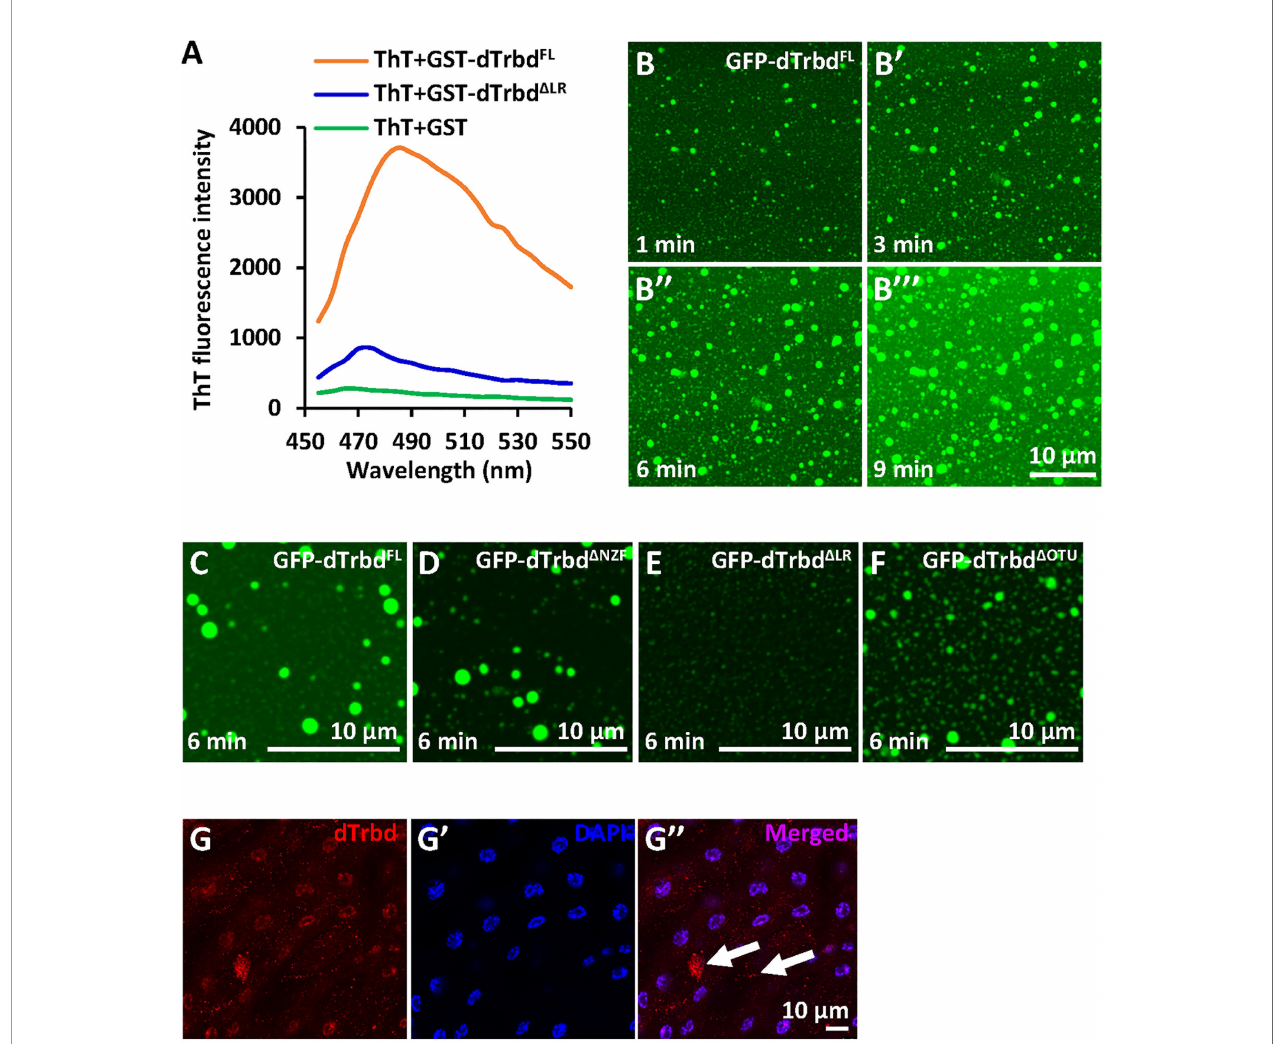
FIGURE 3 | dTrbd undergoes phase separation depending on the Linker region. (A) dTrbd FL but not dTrbd D LR binds to the amyloid binding dye Thio fl avin T (ThT). ( B-B ’’’ ) Phase separation of dTrbd FL at various time points (1, 3, 6, and 9 min, respectively). Scale bars, 10 m m. (C-F) Different truncated forms of dTrbd (dTrbd FL , dTrbd D NZF , and dTrbd D Otu ) can undergo phase separation except dTrbd D LR . Scale bars, 10 m m. (G) Confocal imaging of w 1118 larval fat bodies that were stained with anti-dTrbd (red) antibody. Scale bars, 10 m